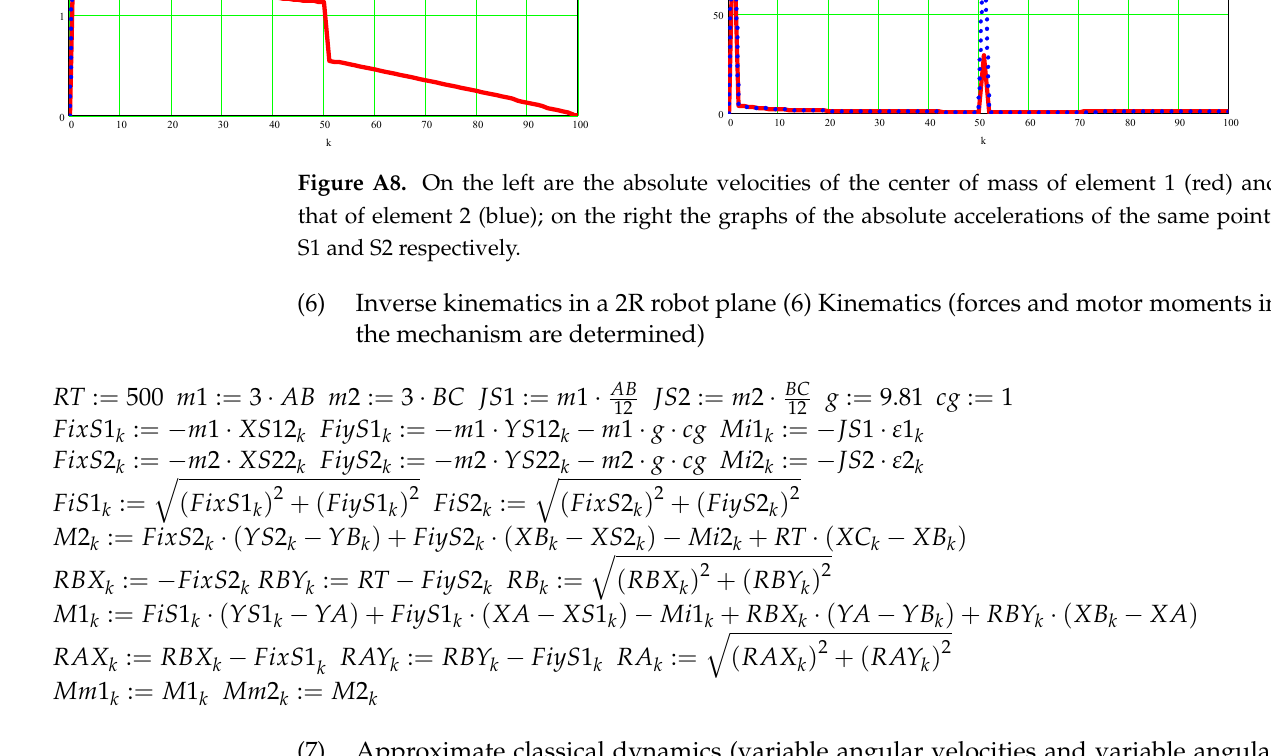
Approximate classical dynamics (variable angular velocities and variable angular accelerations are determined; variation is due to inertial forces or variation in the masses of moving elements), Section